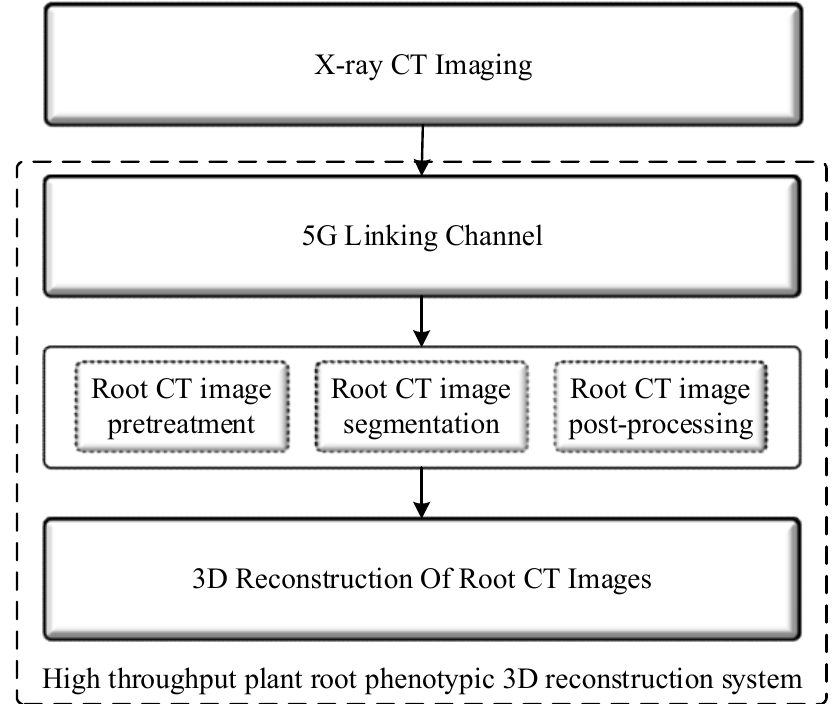
Figure 4. System Model.